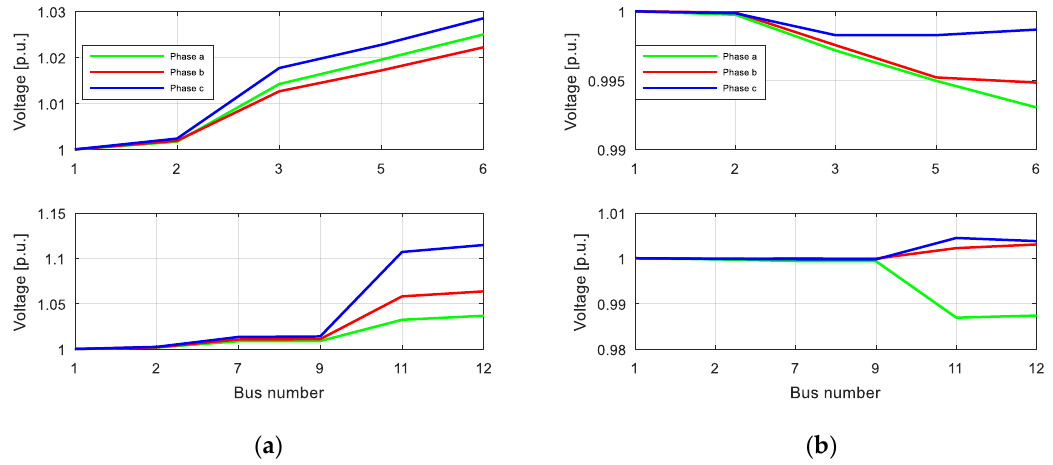
Figure 9 . Scenario 1: Bus voltage profiles for branches B1 (up) and B2 (down) at the hours: ( a ) Peak-H and ( b ) Peak-L.